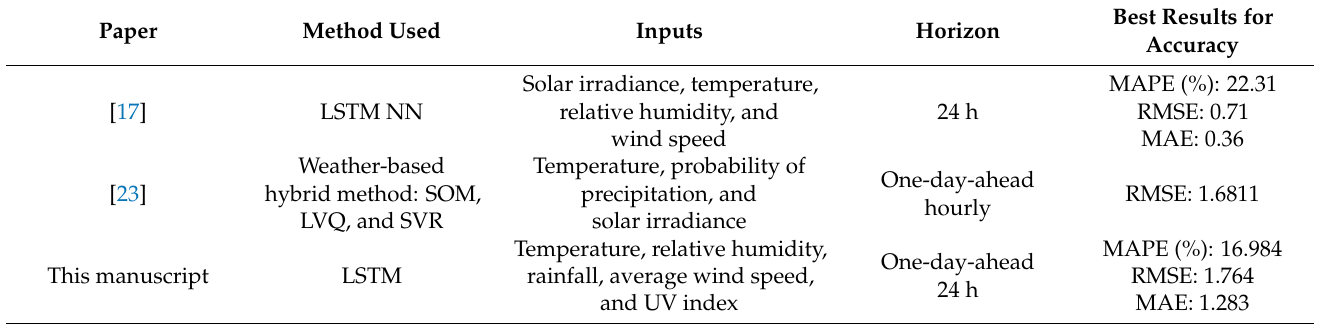
Figure 11. Forecasting results of the LSTM model for the month of June. Table 10. Summary of different algorithms, data inputs, and horizons of one day-ahead PV fore- casting.